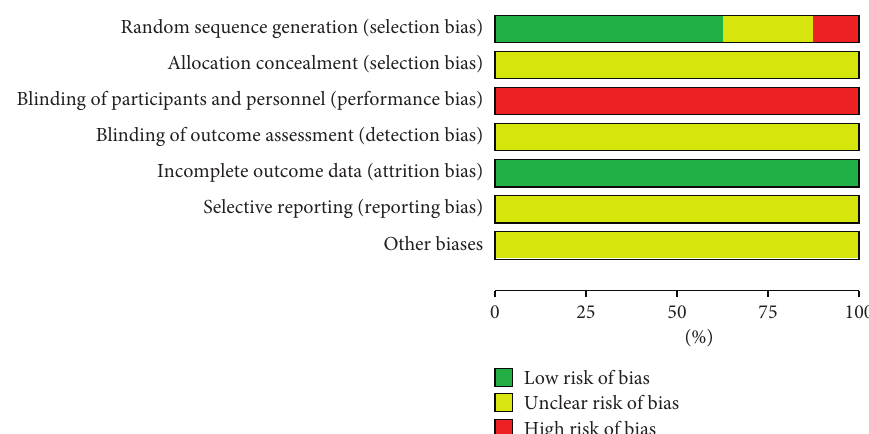
Figure 2: Risk of bias graph: review authors’ judgements about each risk of bias item presented as percentages across all included